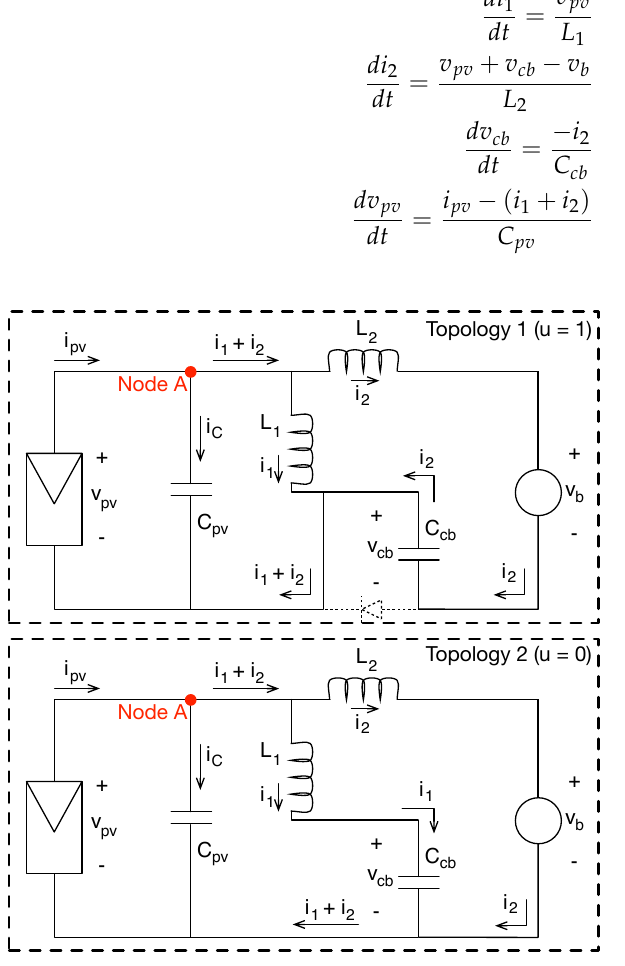
Figure 3. Topologies of the PV system based on the NEC boost